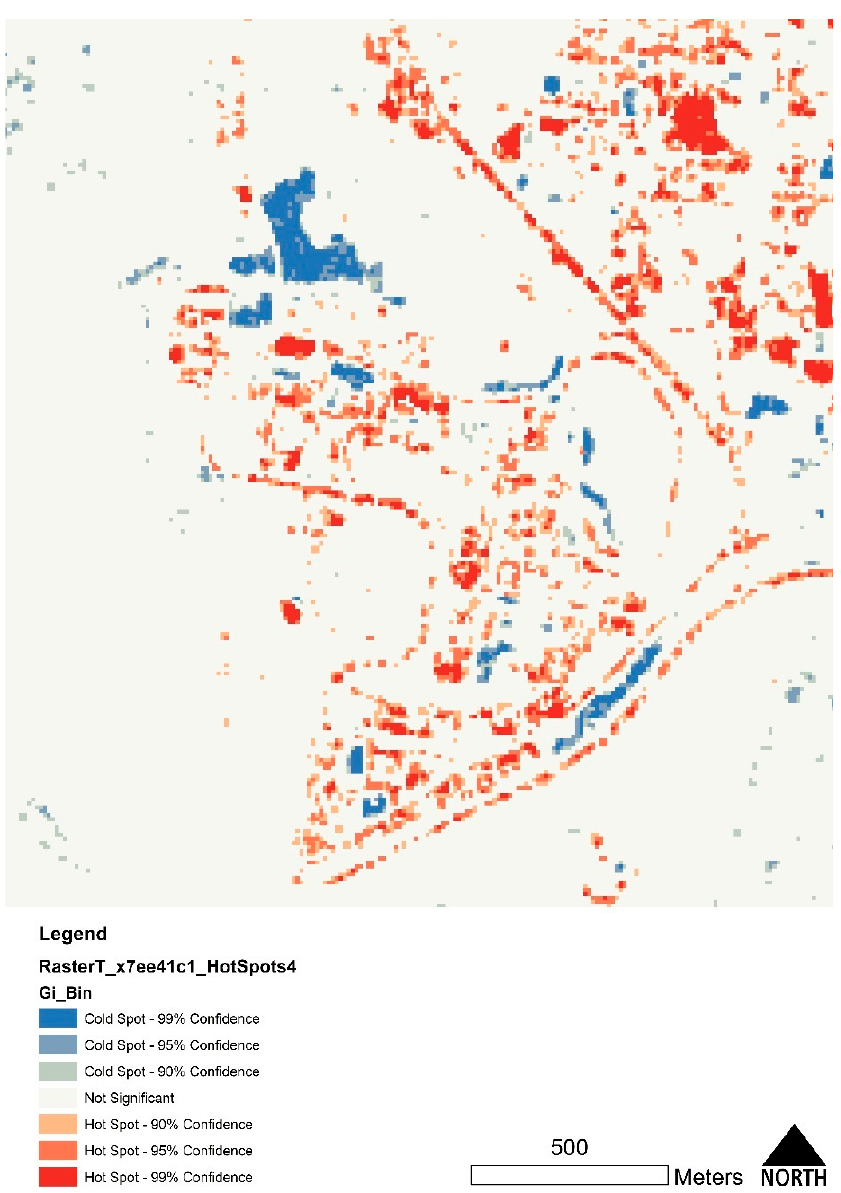
Figure 3. The final map of NDVI abrupt changes. We called these hotspots “NDVI abrupt changes” since they represented the small portions of campus land that, according to NDVI analytical comparison, recorded signifi- cant decreases in values. Once extracted and analyzed, the selected features decreased the NDVI by about 41% on average. We then concentrated our attention on six selected